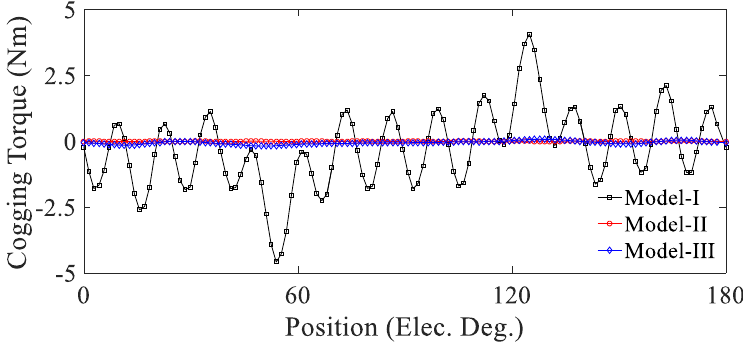
Figure 17. Cogging torque of the optimized models.